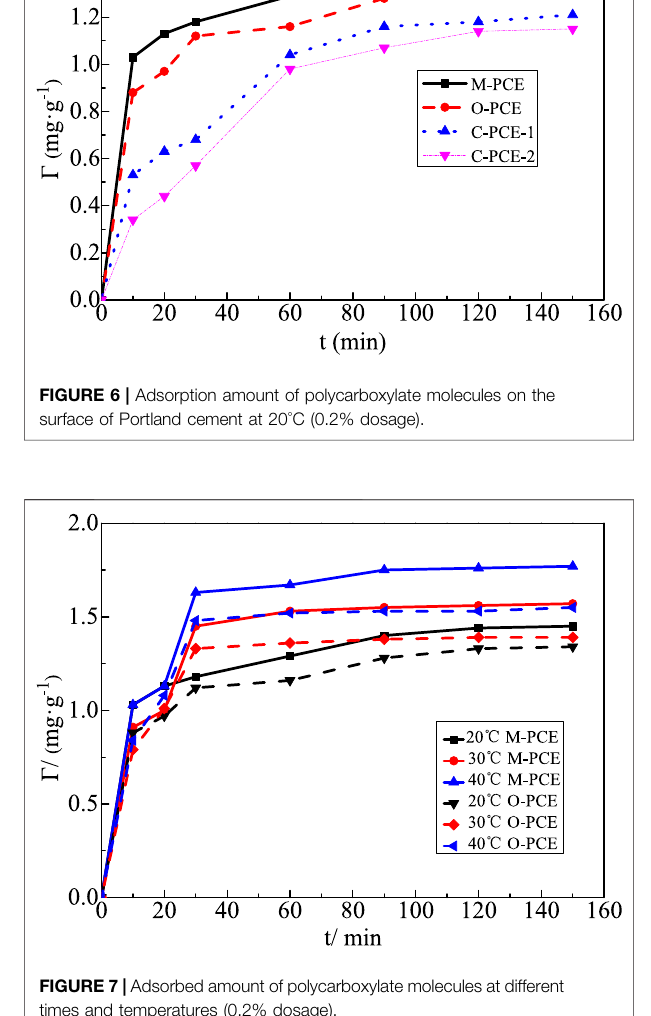
Frontiers in Materials |